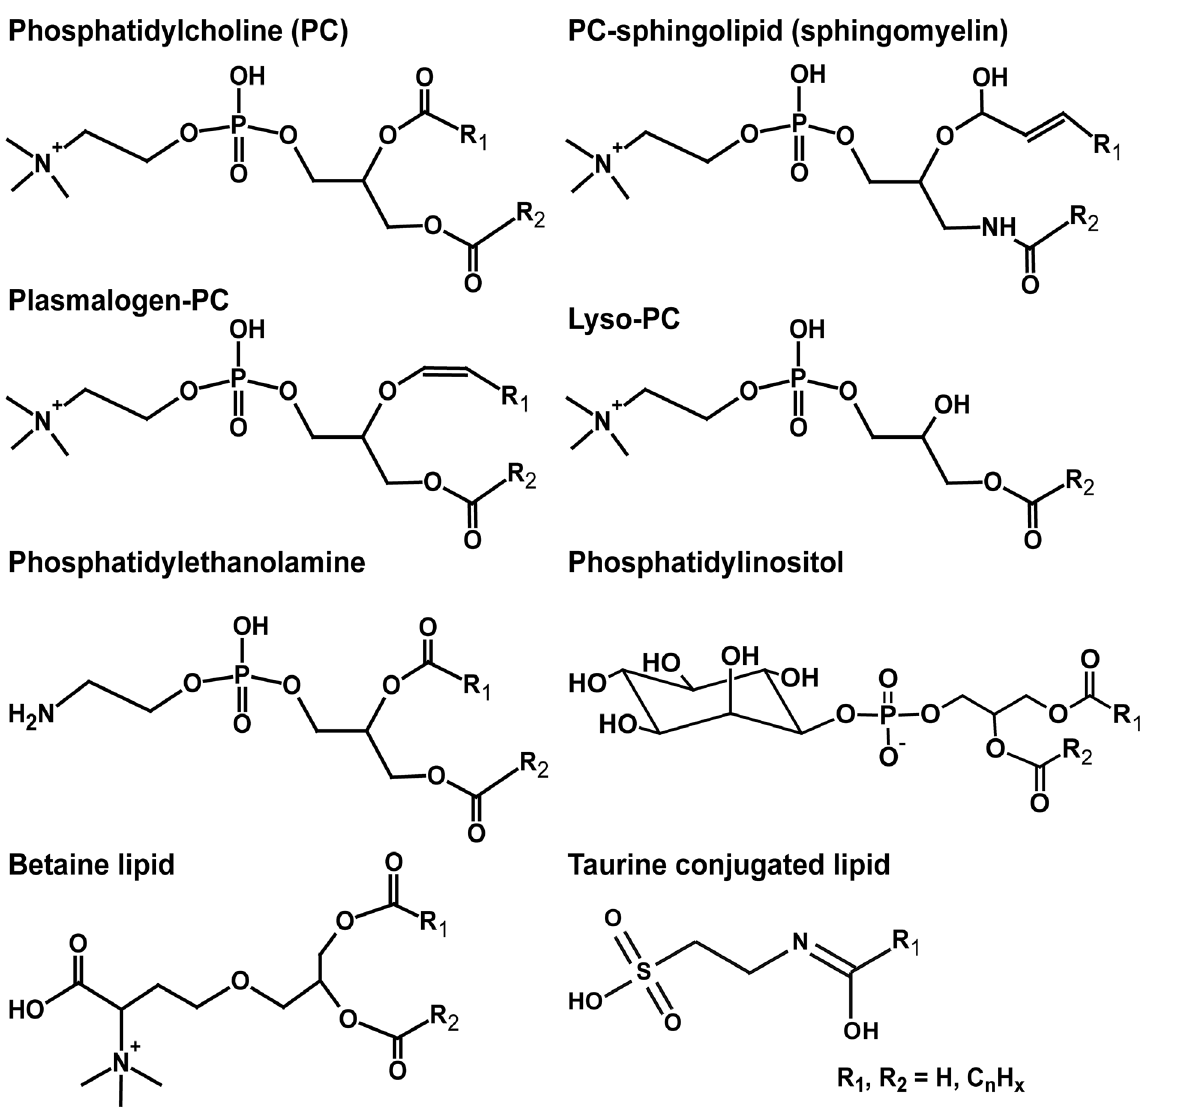
Fig 3. Structures of identified intact polar lipids in lipid extracts of animal tissues. PC = phosphocholine.